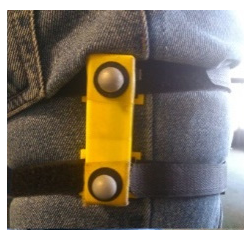
Figure 1. Attachment of IMU to the reference thigh of the subjects.